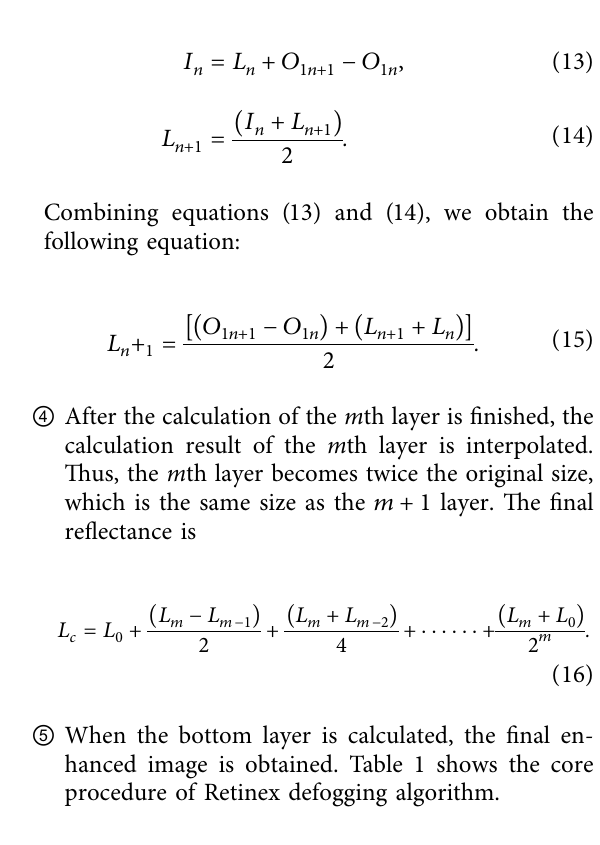
Figure 3: Schematic of the Retinex algorithm